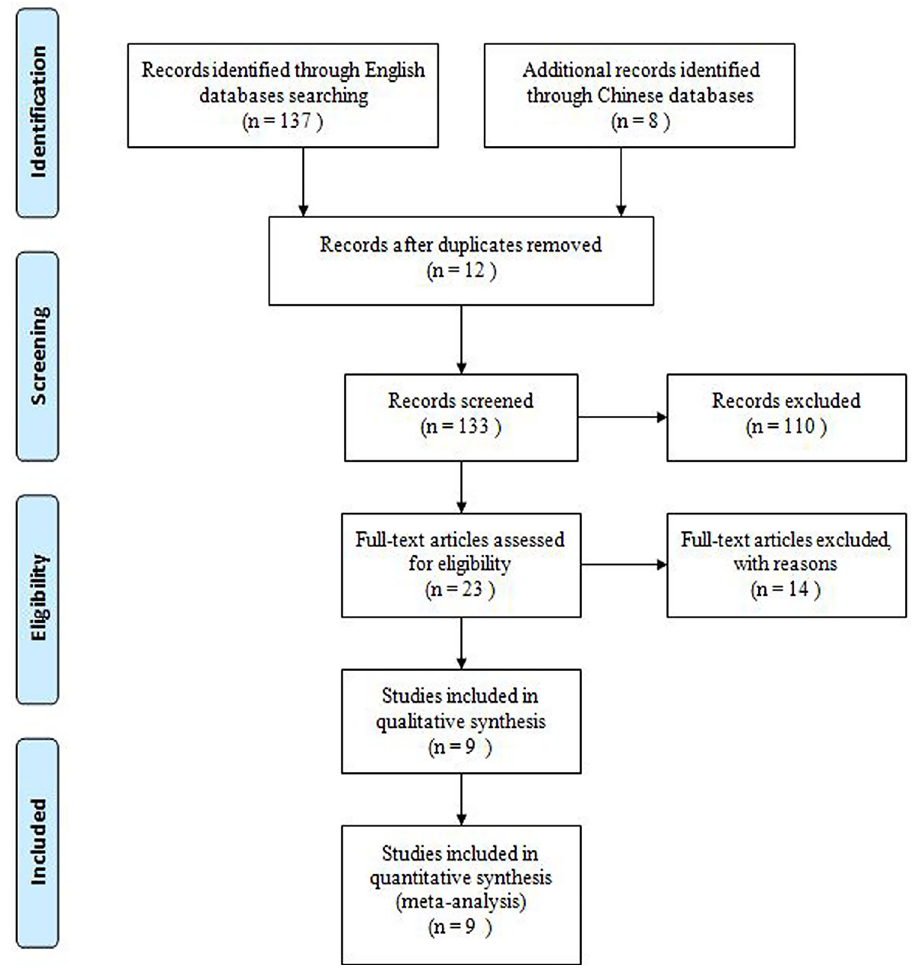
Fig 1. Flowchart of study